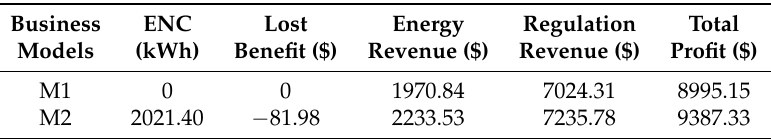
Table 2. Optimal results under M1 and M2 (one day).